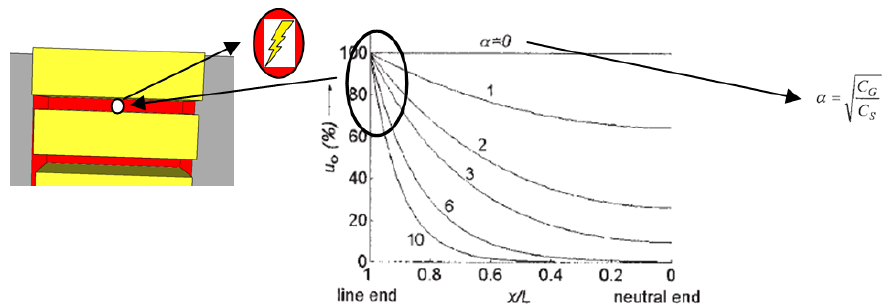
Figure 13. During short transients, such as a voltage surges, the windings ( a ) are modelled as distributed elements: capacitors, inductors and resistors, ( b ). Insulation wall between the copper strand and the iron core is seen as distributed capacity (Cg), insulation between copper strands is also seen as distributed capacity (Cs) and even if distributed inductors are presented, they can be ignored in most cases.